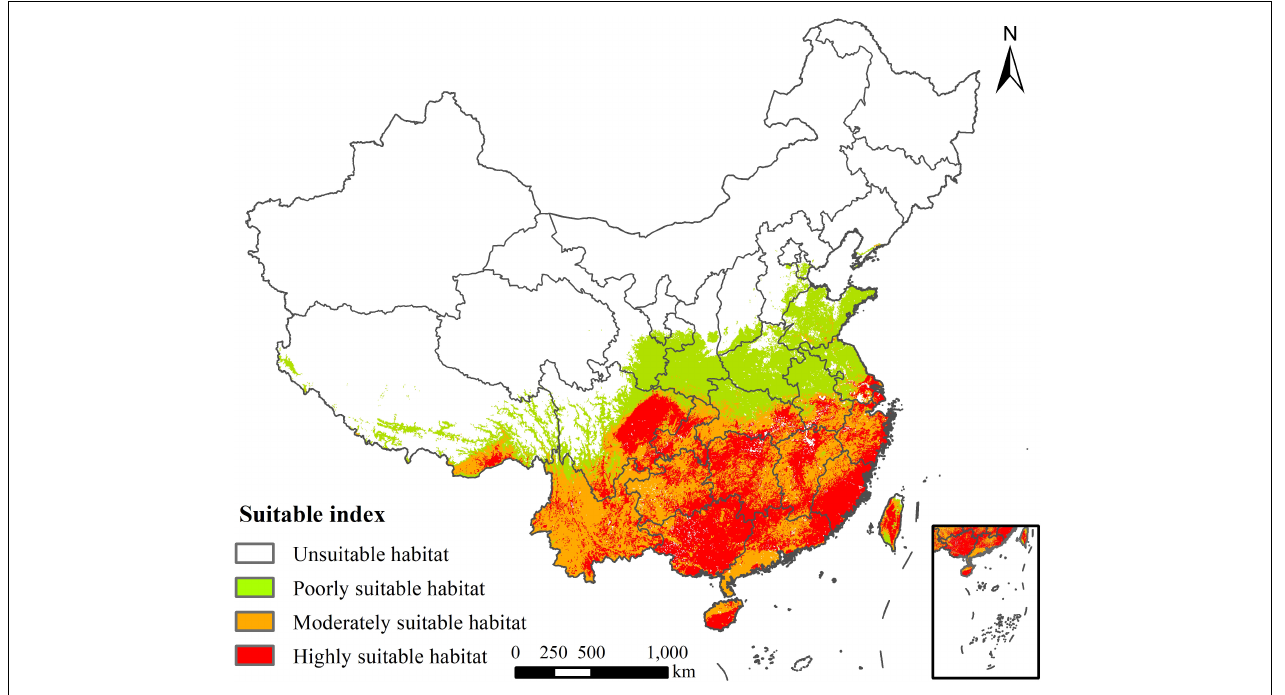
FIGURE 7 | Potential invasive risk areas of Rapistrum rugosum in